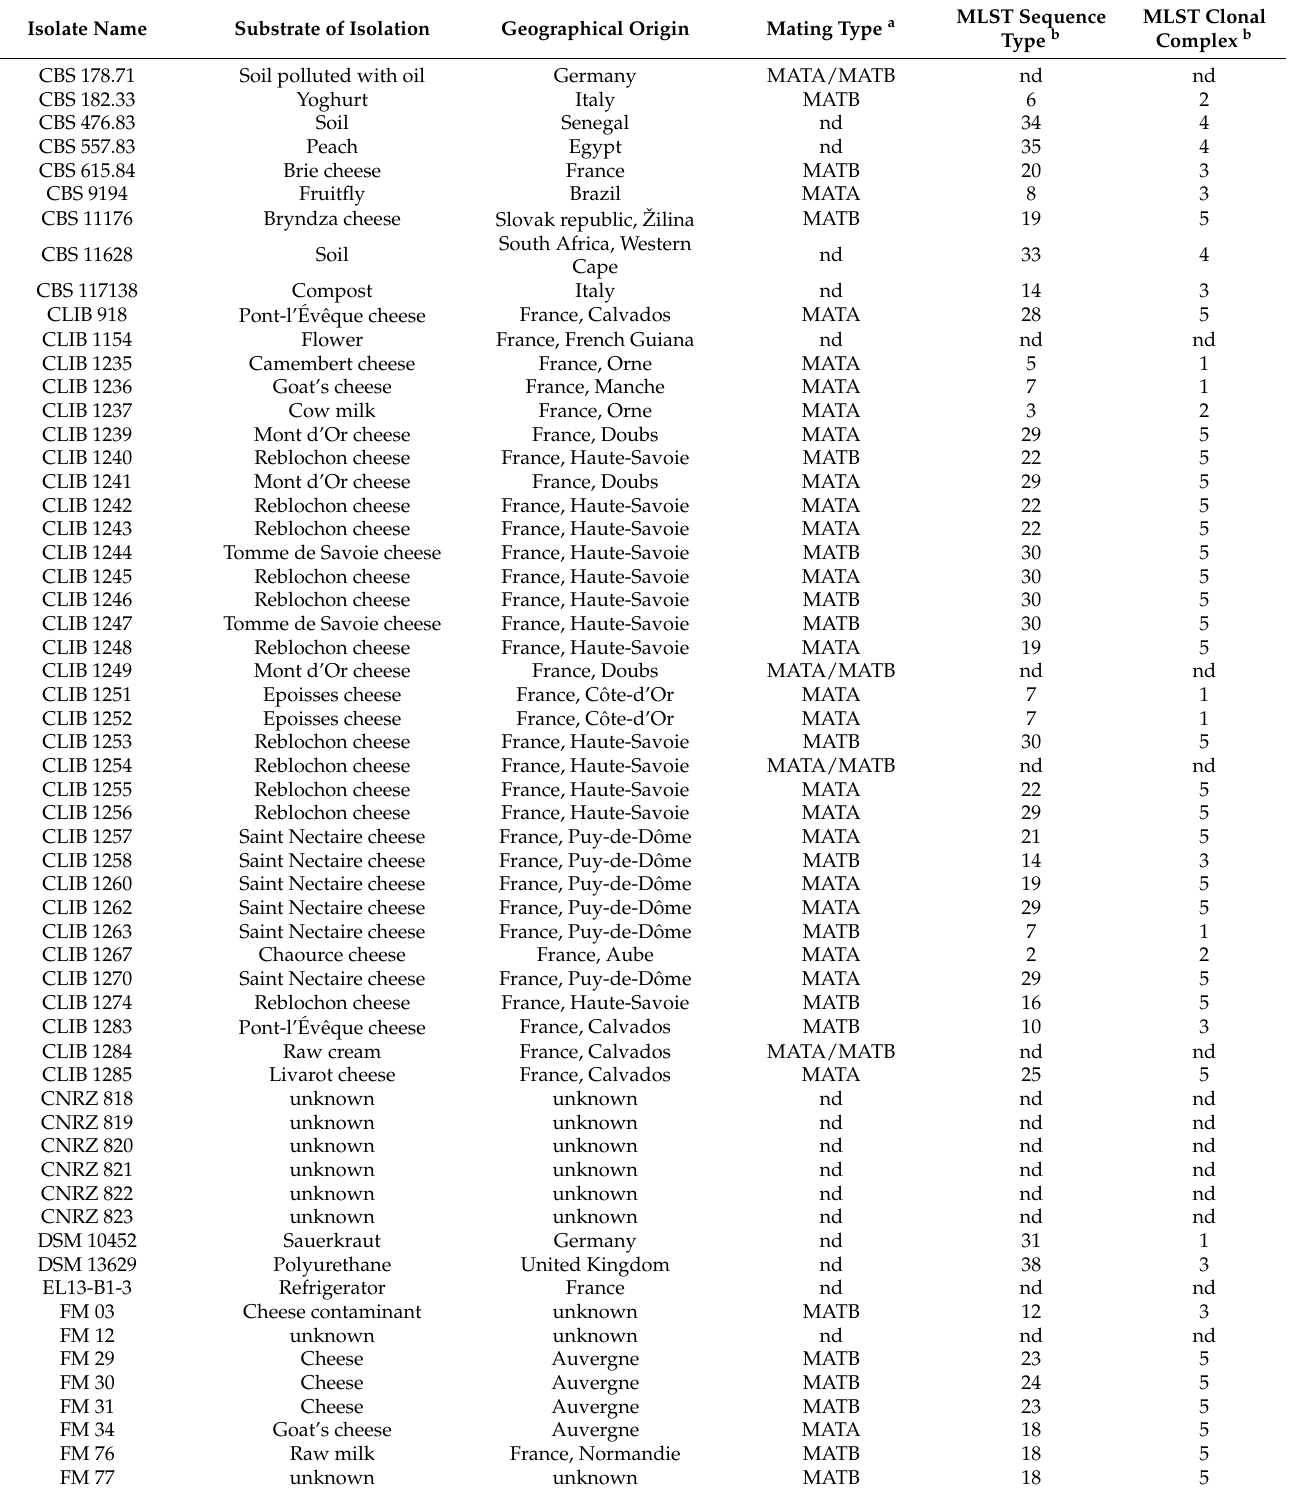
Table 1. Strains used in this